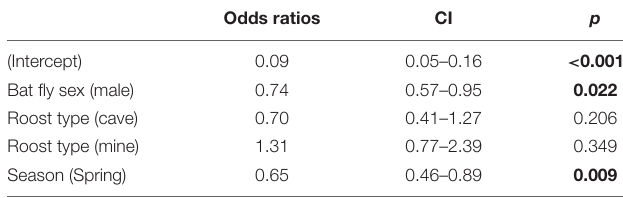
TABLE 2 | Results of our modeling approach